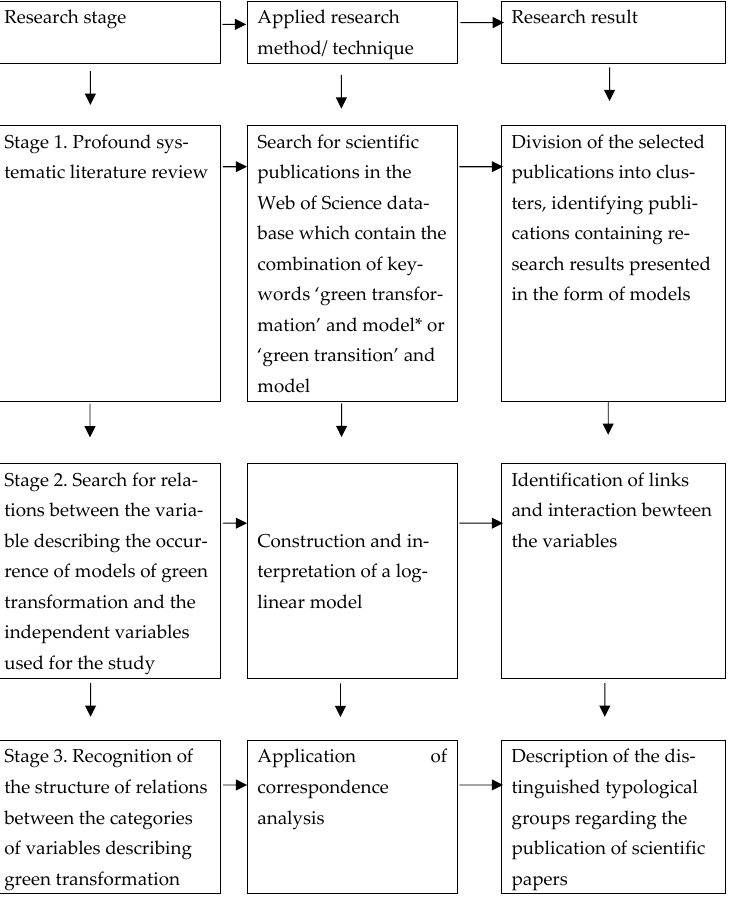
Figure 2. Research procedure chart, where * denotes the possibility of different inflectional forms of a word.